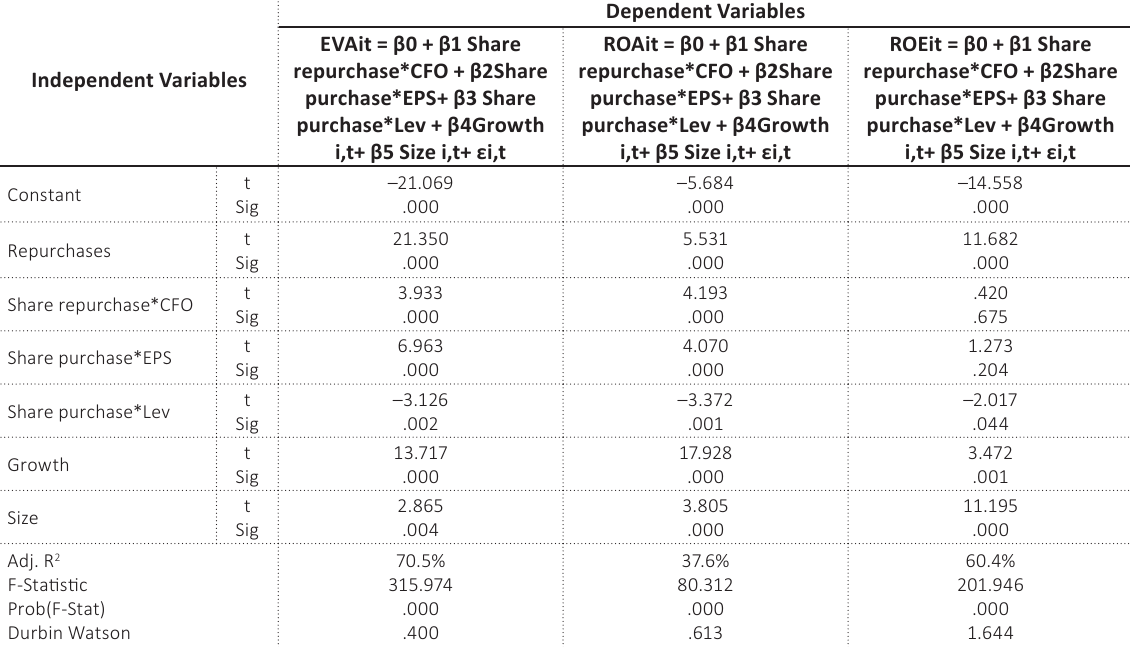
Table 9. The interactive effect for the aggregated share buyback motives and share buyback on financial performance